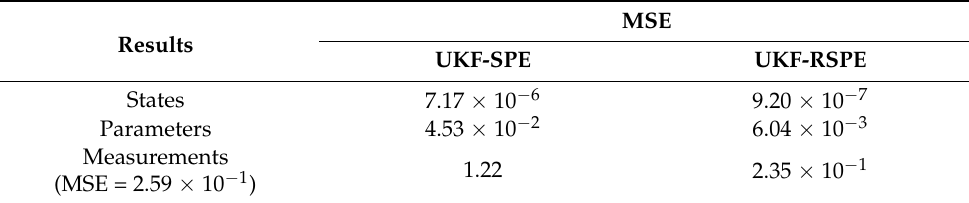
Figure 16. The comparison of the reconciled results of measurement C p in Case Study 2.2: ( a ) reconciled measurement; ( b ) measurement error. Table 6. Statistical information of the estimated results in Case Study 2.2.